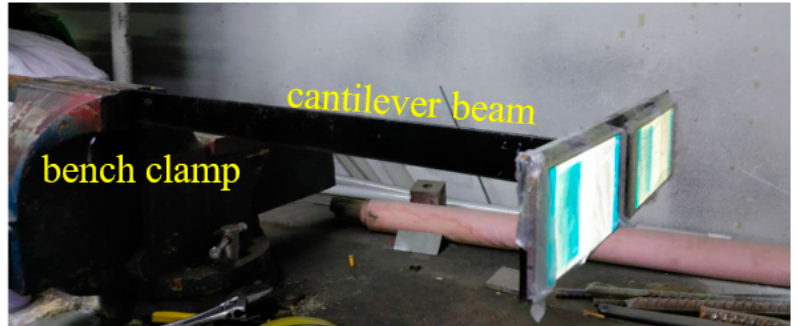
Figure 16. Setup of test.